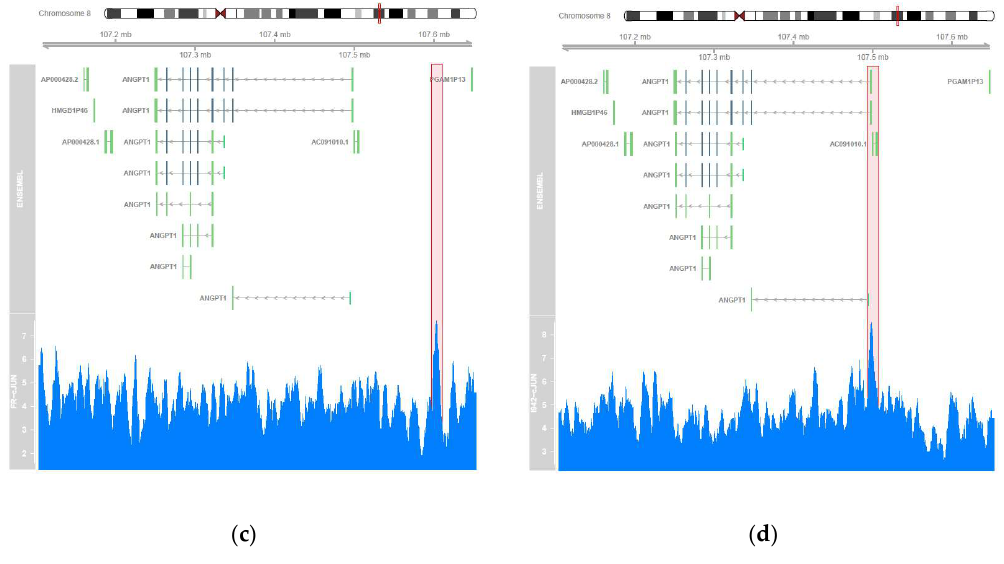
Figure 6. HUVECs were stimulated for 48 h with ( a ) F/R or ( b ) 100 μM I942 or and then total cell RNA was extracted and subjected to RT-PCR using a RT2 Profiler™ PCR Array for Human Endothelial Cell Biology as described in Materials and Methods. The bar graph is coloured to show genes that were identified by ChIP-SEQ as interacting with either C/EBPβ (yellow), c-Jun (red) or both C/EBPβ and c-Jun (green). Plotted in ( c ) and ( d ) is the region for ANGPT1, which interacts with c-Jun and is induced by both F/R ( a ) and I942 ( b ), along with the sequence read coverage (in blue) in that region from alignments. Stimulation with either F/R ( c ) or I942 ( d ) results in a peak immediately up-stream of the ANGPT1 gene, although the binding site appears different for each stimulus.